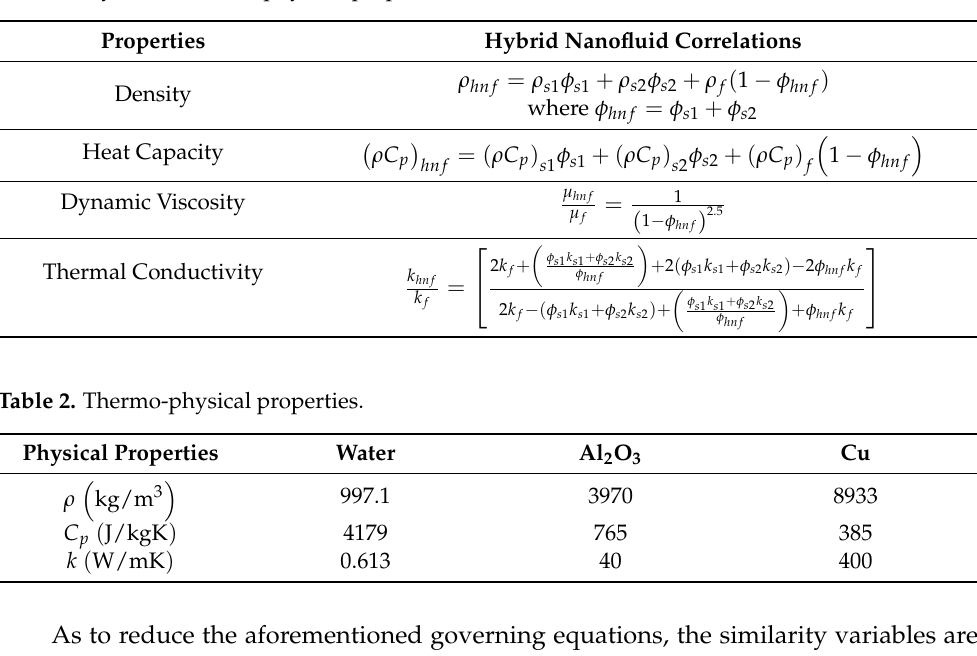
Table 1. Hybrid nanofluid physical properties.